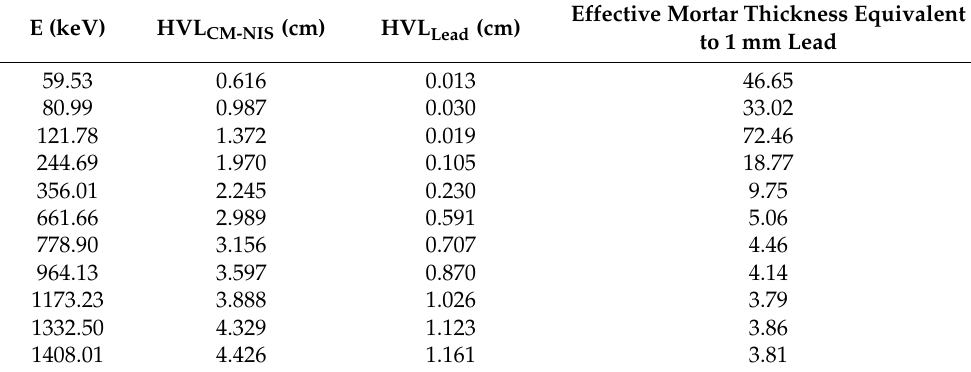
Table 8. The values of ratio of HVL for NIS sample and